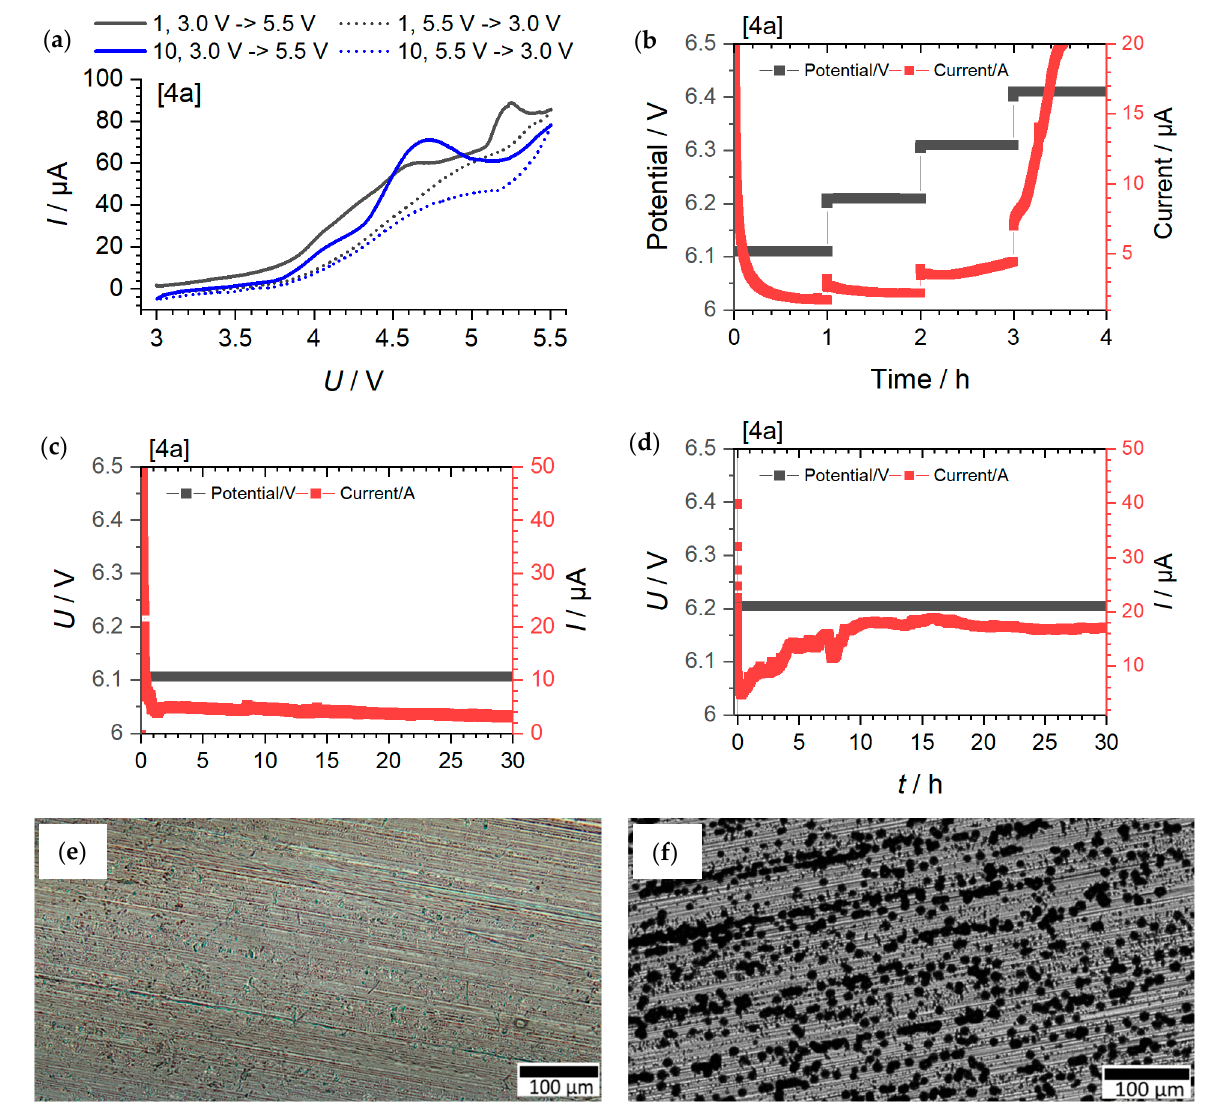
Figure 8. Aluminum corrosion tests exemplarily shown for electrolyte mixture [4a]. ( a ): Cyclic voltammetry (CV) measurement of Al//Li cells between 3.0–5.5 V vs. Li/Li + of cycle 1 and cycle 10. ( b ): Polarization step method (Al//Li cells) with two descending current profiles (<6.3 V vs. Li/Li + ) and two increasing current profiles ( ≥ 6.3 V vs. Li/Li + ). ( c ): Long ‐ term polarization at 6.1 V vs. Li/Li + and decreasing current profile. ( d ): Long ‐ term polarization of Al//Li cells at 6.2 V vs. Li/Li + and increasing current profile. ( e ): Microscope image of long ‐ term polarization at 6.1 V vs. Li/Li + (cell 8c). ( f ): Microscope image of long ‐ term polarization at 6.2 V vs. Li/Li + (cell 8d) with visible corrosion pits.